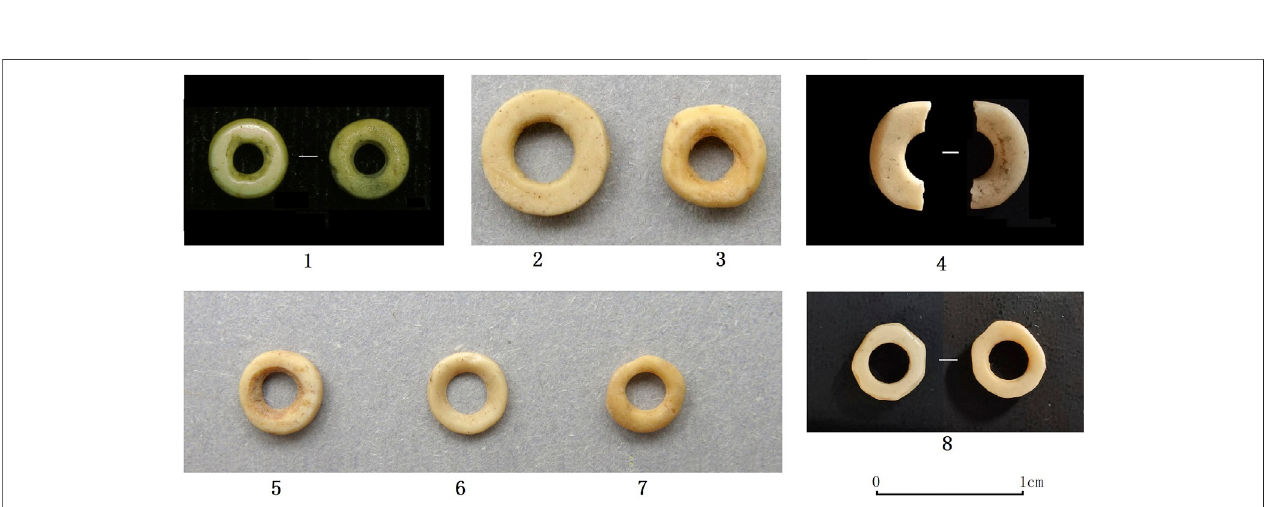
FIGURE4| PerforatedOESbeadsfromSZT29Layer7Spits2 – 1,SZT29Layer7uppercontact,SZT29Layer 2,andSZT12G, alltothesamescale.1.Usedbead fromSZY12G(exteriorandinteriorviews);2 – 3.TwousedbeadsfromSZT29Layer2(exteriors);4.BrokenbeadfromSZT29Layer7uppercontact(exteriorandinterior); 5 – 8. Four used beads from SZT29 Layer 7 Spits 2 – 1: 5-6. Interior; 7. Exterior; 8. Exterior (left) and interior (right)